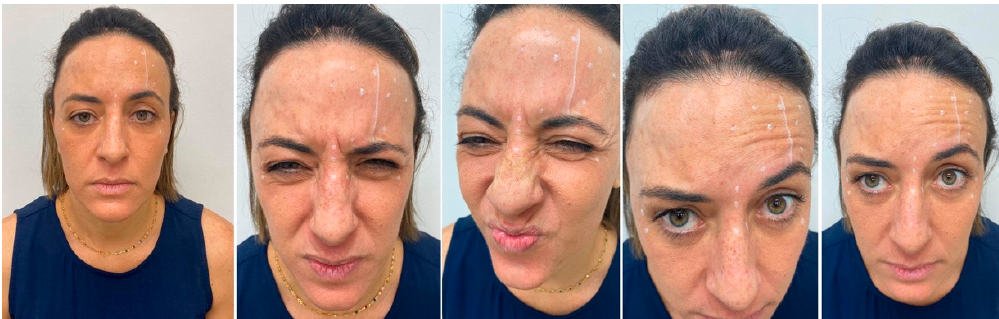
Figure 9. Clinical evaluation for a new application of botulinum toxin.